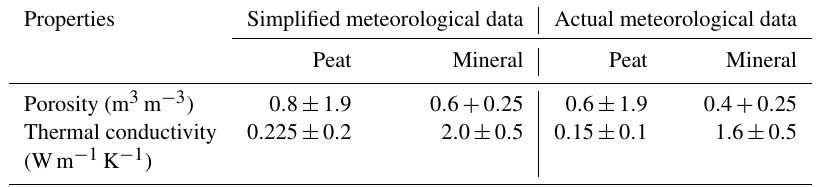
Table 1. Allowed range for the estimated parameters.